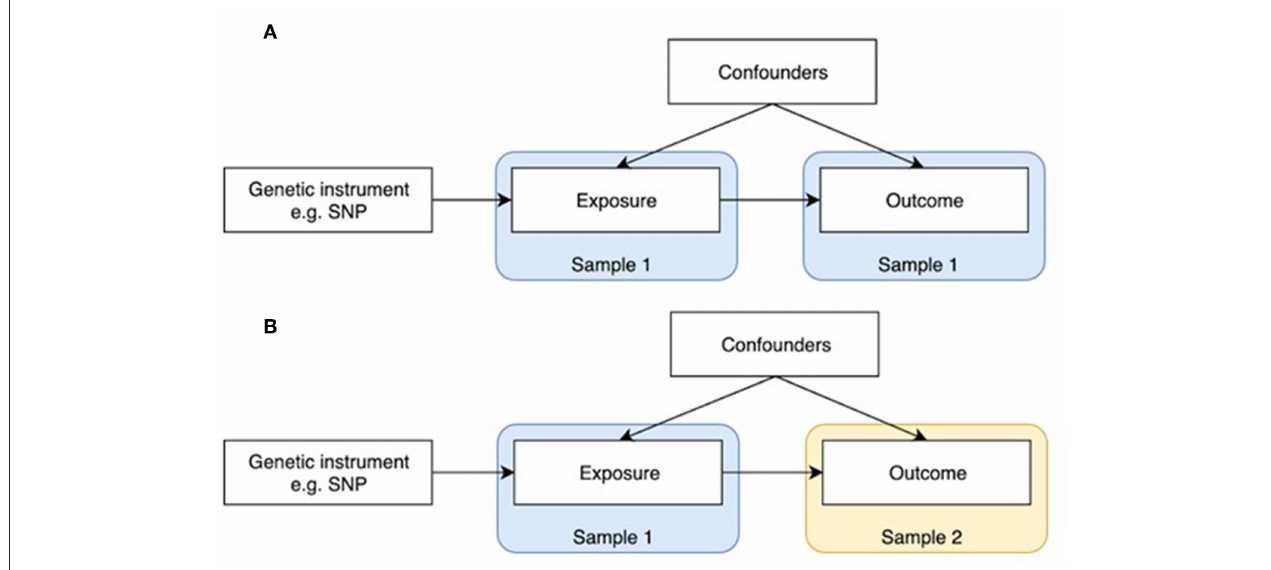
FIGURE 1 | One-sample and two-sample Mendelian randomization study designs. (A) One-sample Mendelian randomization is based on a population where both exposure and outcome have been measured. (B) In two-sample Mendelian randomization, exposures and outcomes are measured in non-overlapping populations. SNP-exposure is derived in Sample 1, and SNP-outcome in Sample